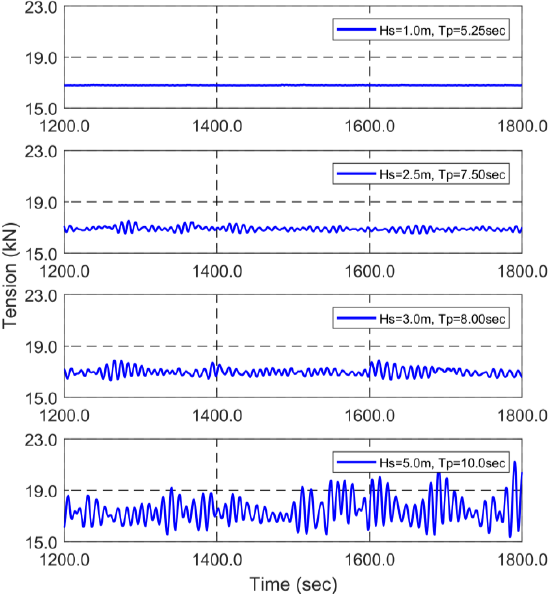
Figure 13. Time histories of mooring tension in different wave conditions under identical current velocity ( V c = 1.0